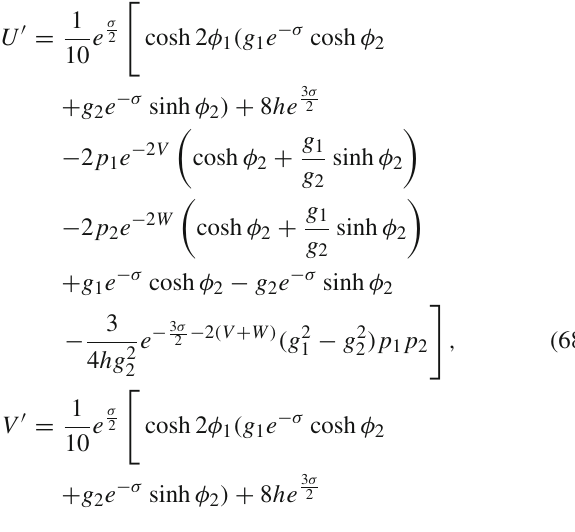
, − 1 ),( 1 , − 1 ),( 1 , − 1 ),( − 1 , 1 ) (blue, yellow, green, 16 4 8 10 4 10 2 3